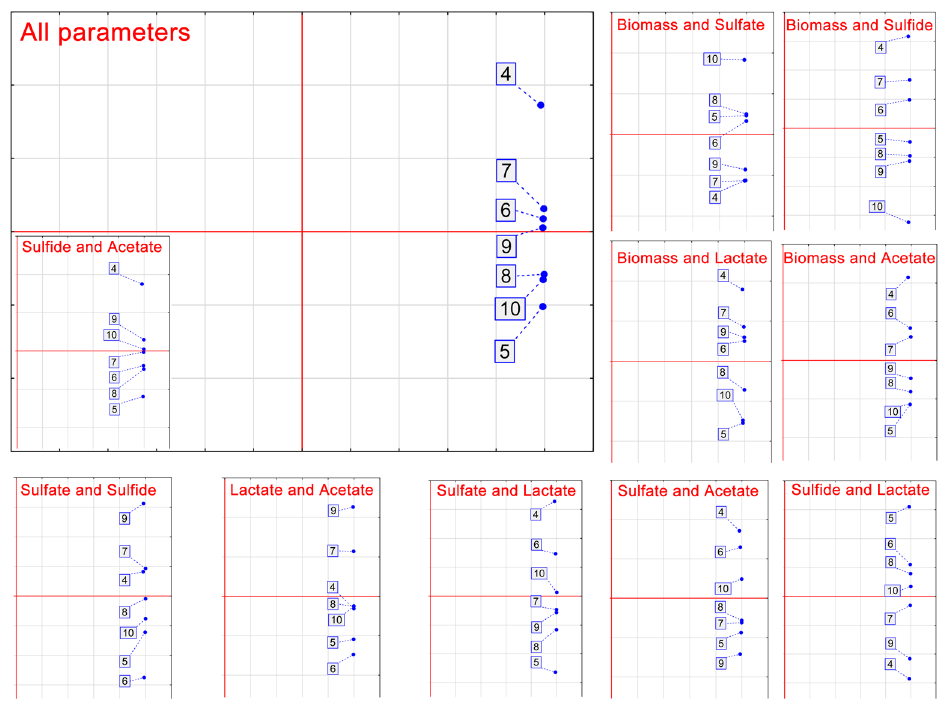
Figure 5: Principal component analysis of the D. piger Vib-7 growth and the parameters of sulfate reduction under the effect of pH